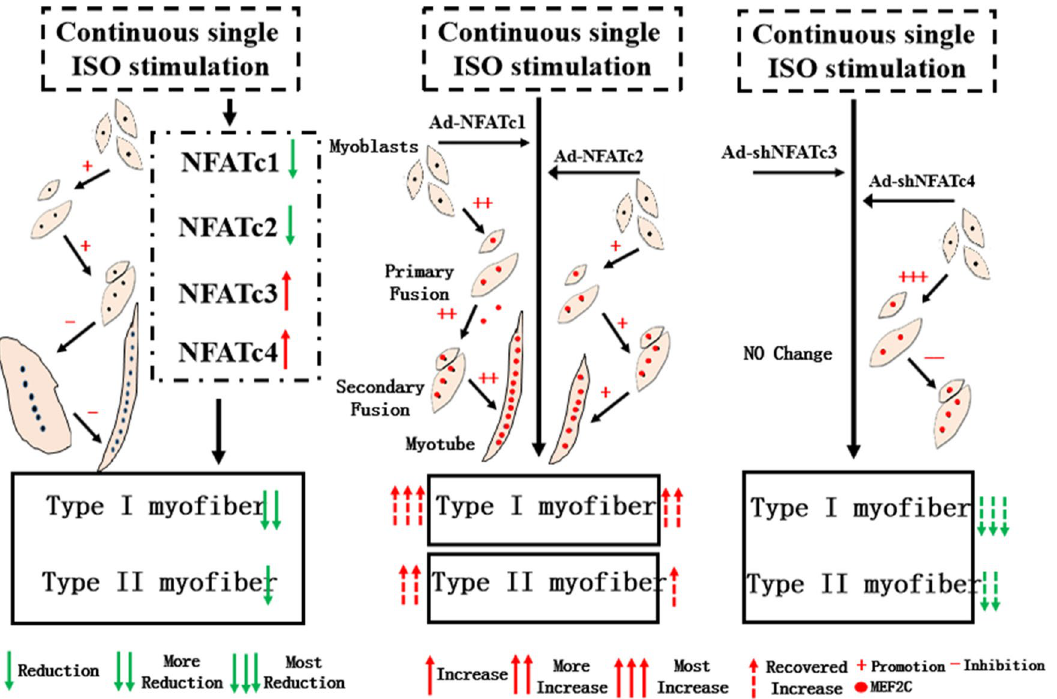
Figure 10. Working model: Continuous exposure to isoprenaline inhibited myoblast differentiation and fusion and altered muscle fiber specialization through the NFAT-MEF2C signaling pathway. NFATc1 signaling controlled the changes in ISO-reduced type I muscle fibers with the help of MEF2C; NFATc4 signaling controlled the changes in type II muscle fibers mediated by ISO in an MEF2C-independent